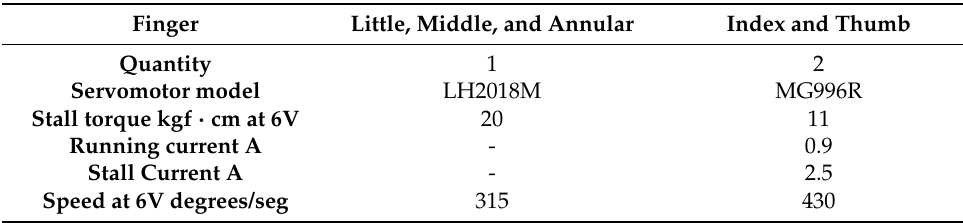
Table 6. Actuators selected to implement the drive pulley